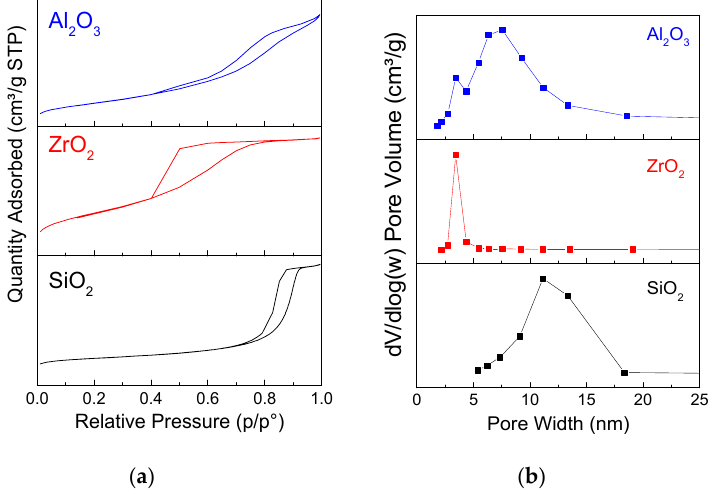
Figure 1. N 2 adsorption-desorption isotherms ( a ) and pore size distribution ( b ) of the bare supports. Table 1. Textural properties for the supports and the resulting catalysts.